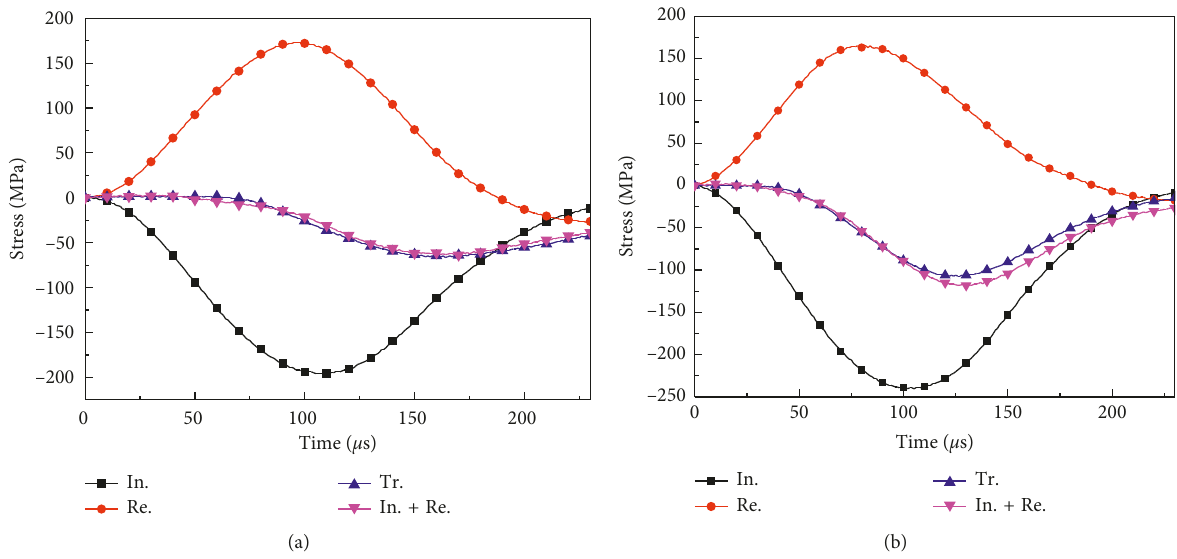
Figure 5: Typical dynamic stress equilibrium results at unreinforced and reinforced conditions. (a) US-4. (b) RS-4.